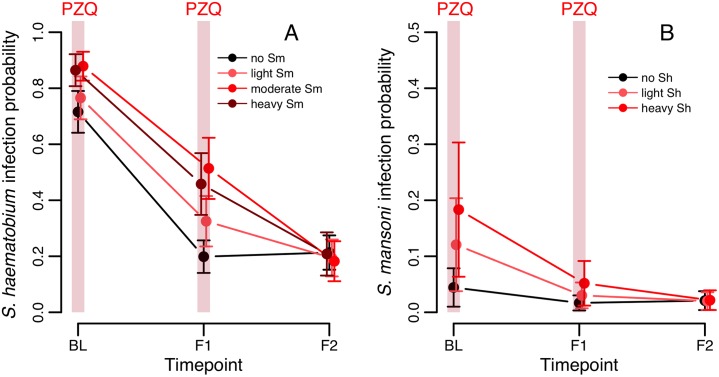
Predicted changes in the probability of (A) S. haematobium and (B) S. mansoni infection, over successive rounds of treatment in the Malian cohort according to co-infection status at baseline.Values shown are (cluster-specific) predicted values and standard errors from a binomial mixed model, for a child of average age in the dataset. BL = baseline, F1 = first annual follow-up1, F2 = second annual follow-up.